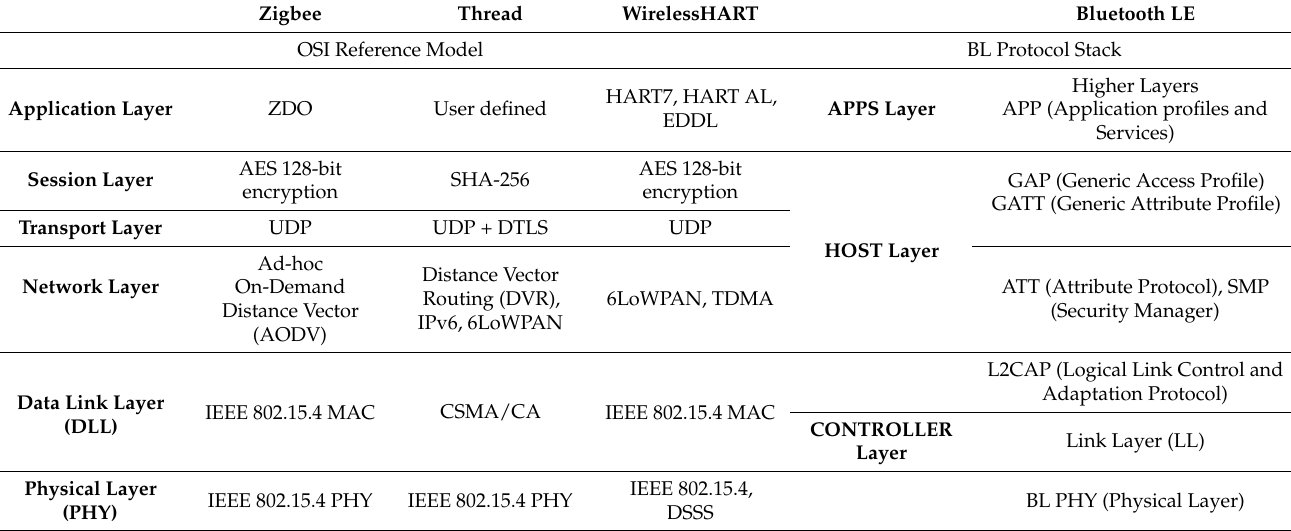
Table 1. Low-Rate Network Standards and Protocols (relevant for this research).